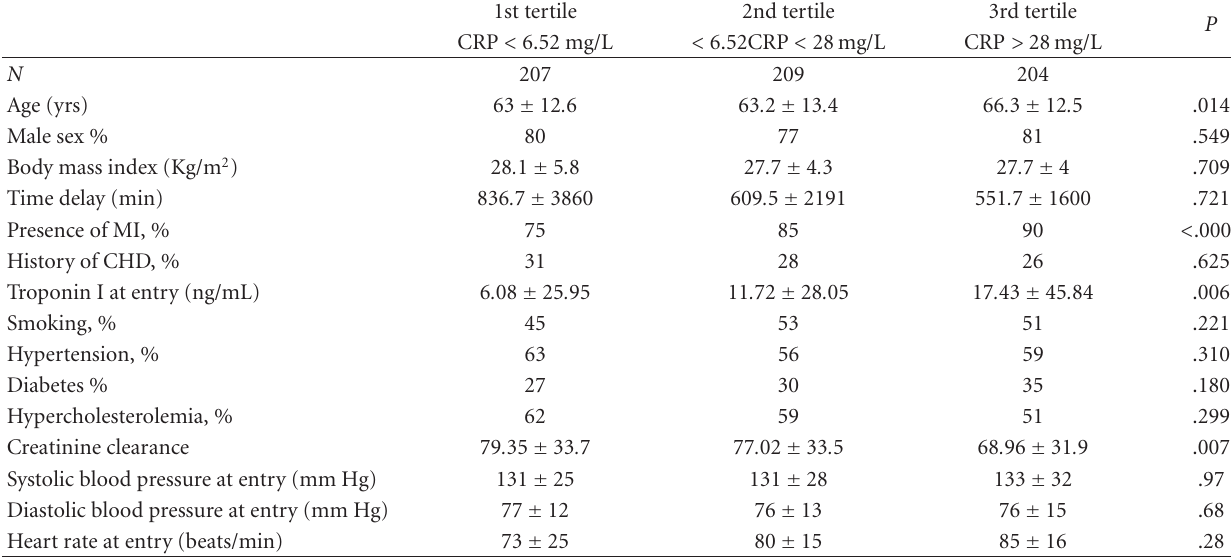
Table 3: Results from ANOVA that presents the distribution of clinical and biochemical characteristics among CRP tertile. 1st tertile 2nd tertile 3rd tertile P CRP < 6.52